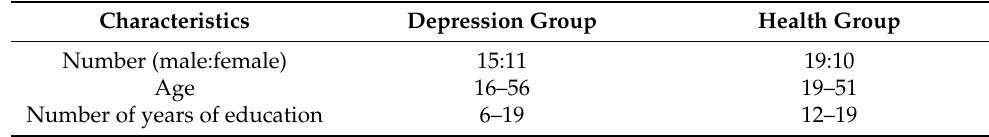
Table 1. Participant demographic characteristics.